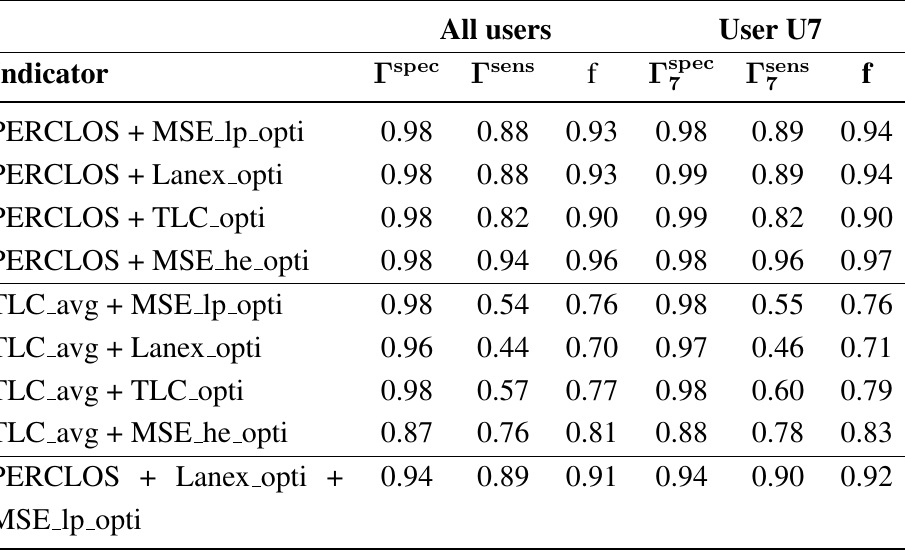
Table 6. Possible combinations of indicators